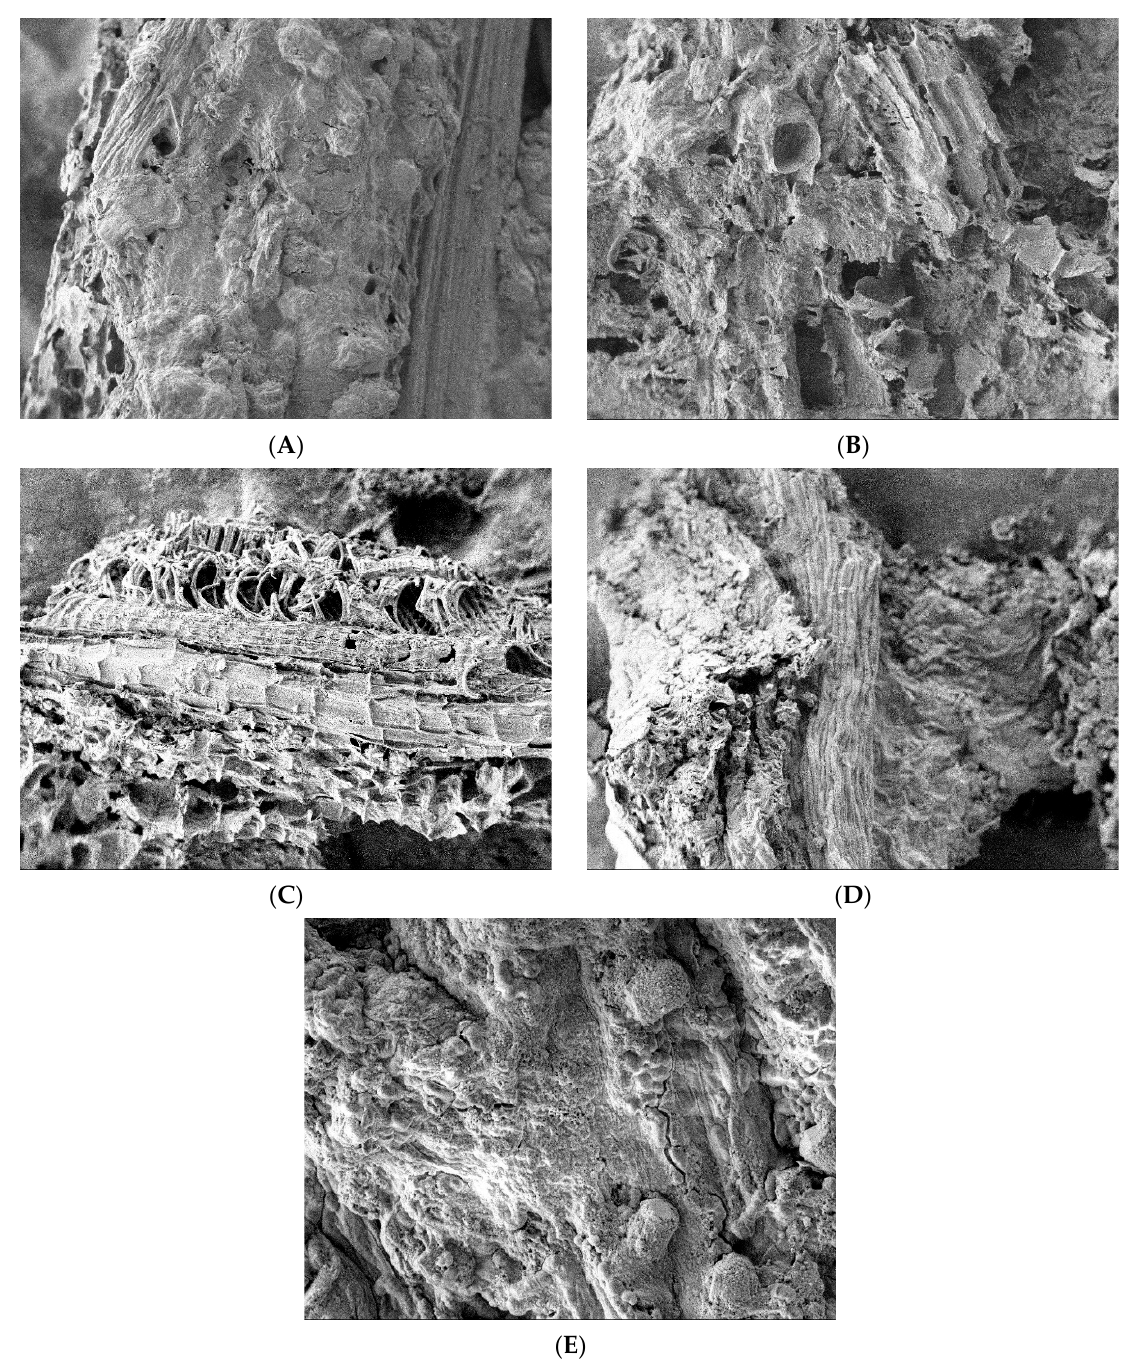
Figure 1. SEM images of APRc: ( A ) untreated; ( B ) treated with NaOH; ( C ) treated with cellulase enzyme; ( D ) treated cellobiohydrolase enzyme; ( E ) treated with HCl. (The figures ( A – D ) where with a resolution ×200 and 100 µm; fi gure ( E ) with a resolution ×5000 and 1 µm).